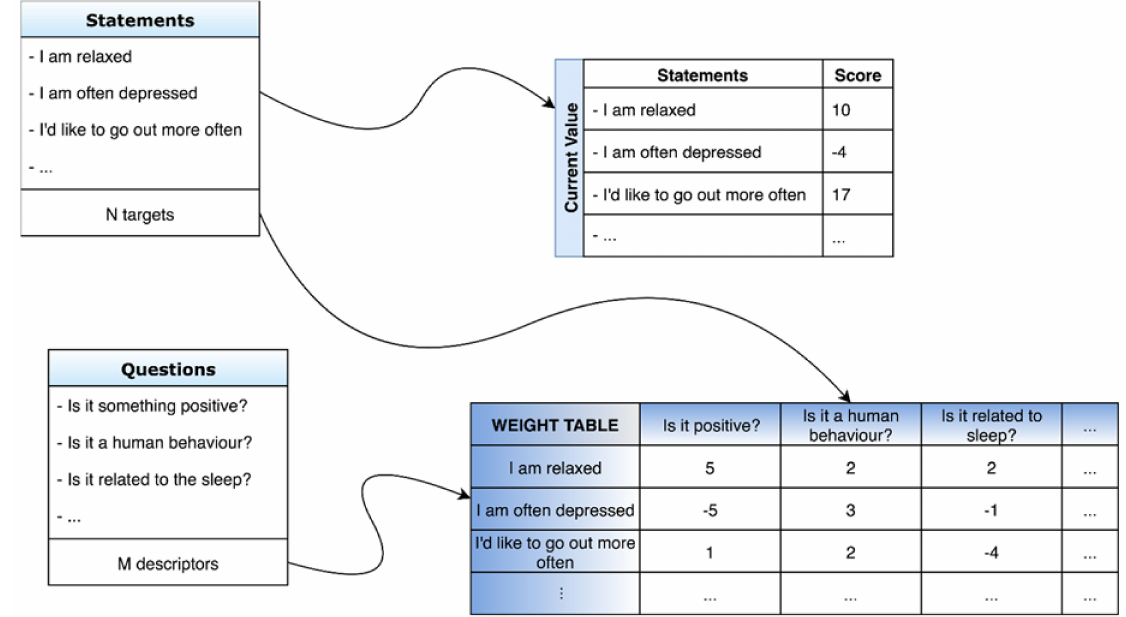
Figure 2. Structure of the artificial neural network. In particular, the structure of the databases of statements and questions, of the table of current values, and of the weight table are